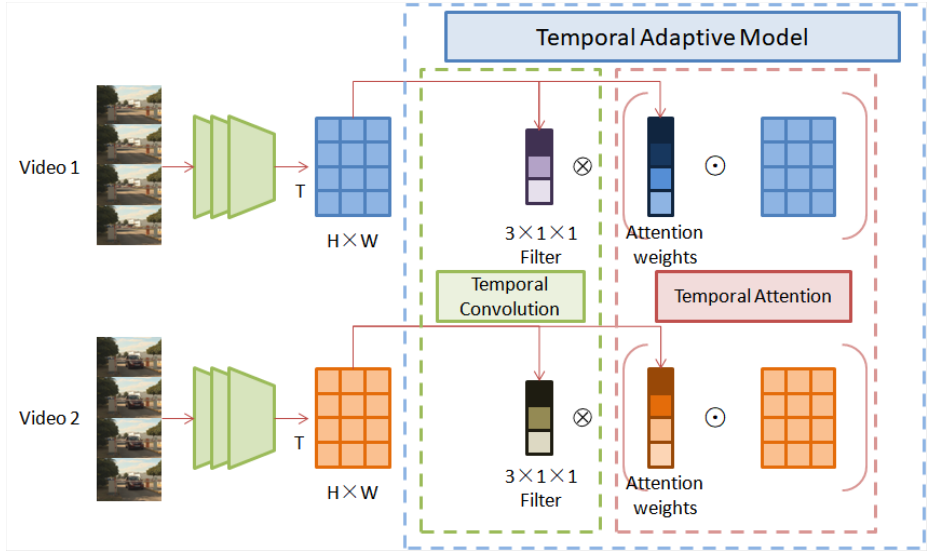
Figure 2. Two parts of temporal adaptive